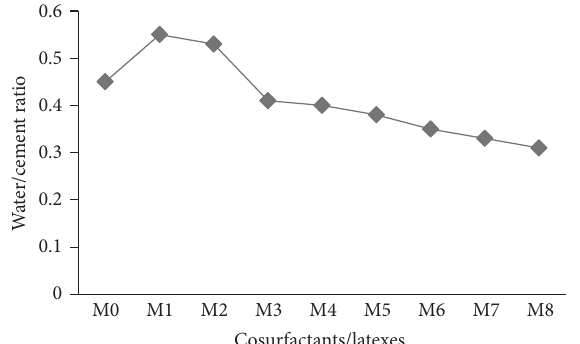
Figure 3: The effect of cosurfactants and copolymer latexes on the water/cement ratio of mortar.